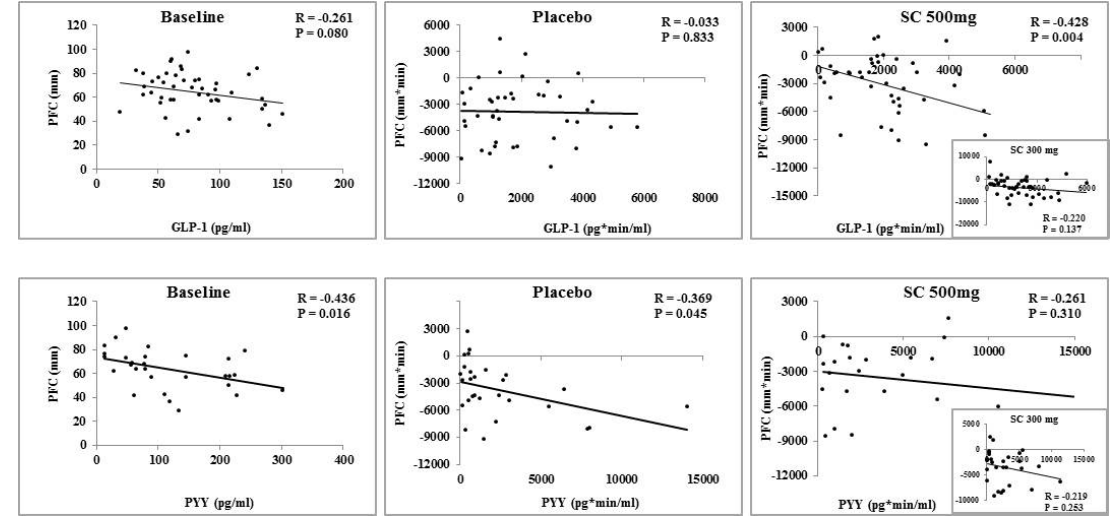
Figure A2. Correlations of gut hormones (GLP-1, PYY) and prospective food consumption (PFC) at baseline, and after the meal with placebo or SC treatment (SC 300 mg, SC 500 mg) using area under the curve.